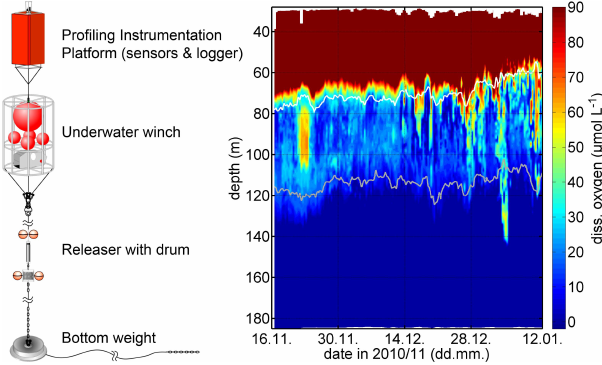
Fig. 2. Left-hand panel: sketch of the GODESS profiling moor- ing with profiler, underwater winch, releaser with recovery line and bottom weight (from top to bottom) in the Gotland Basin. Right- hand panel: dissolved-oxygen concentration for a 56-day deploy- ment in the central part of Eastern Gotland Basin (16 November 2010 to 11 January 2011), measured with a Rinko III oxygen optode from JFE Advantech Co., Ltd. (Japan). All concentrations above 90µmolL − 1 are plotted in red. White and gray lines denote the 8.0kgm − 3 and 9.5kgm − 3 isopleths, respectively, of the density